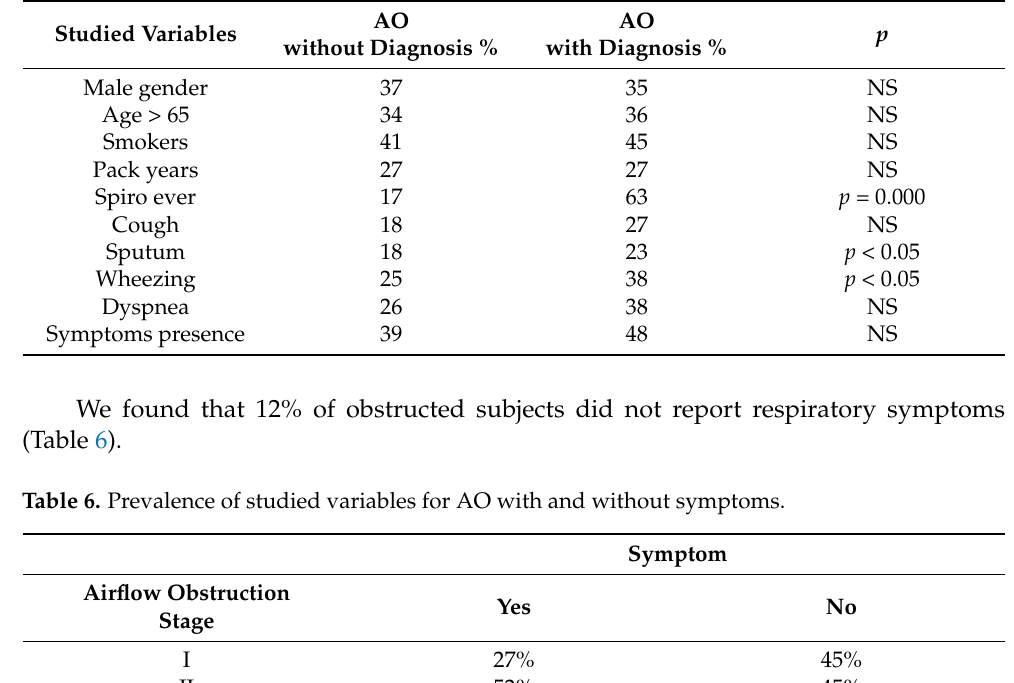
Table 5. Obstruction severity prevalence for each physician diagnosis subgroups.